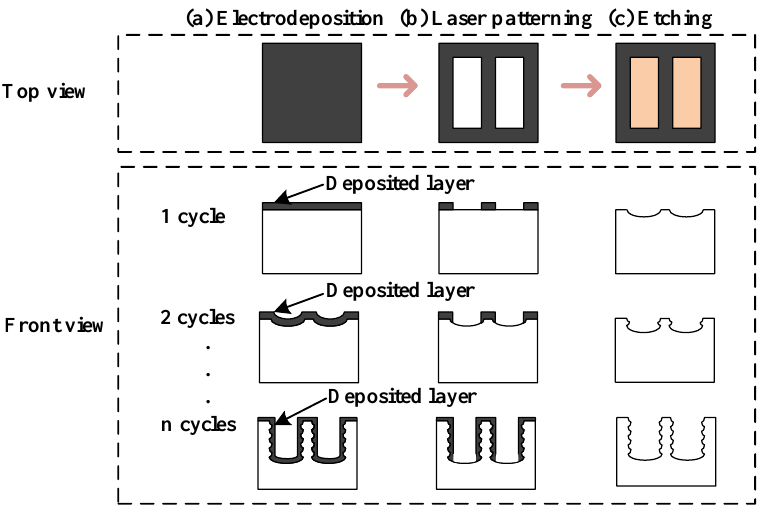
Figure 2. Procedures for DEE process; ( a ) electrodeposition, ( b ) patterning by laser irradiation, and ( c ) electrochemical etching.